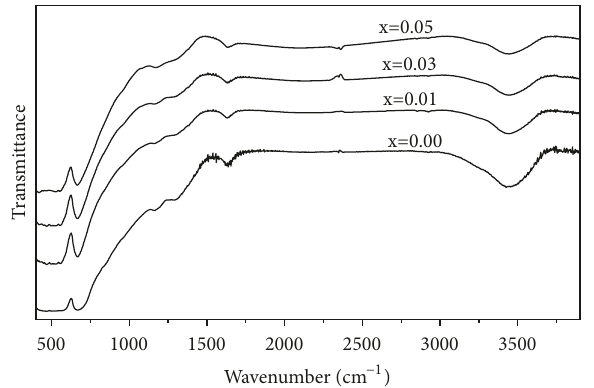
Figure 4: FT-IR spectra of Gd(Al 1 phosphors.